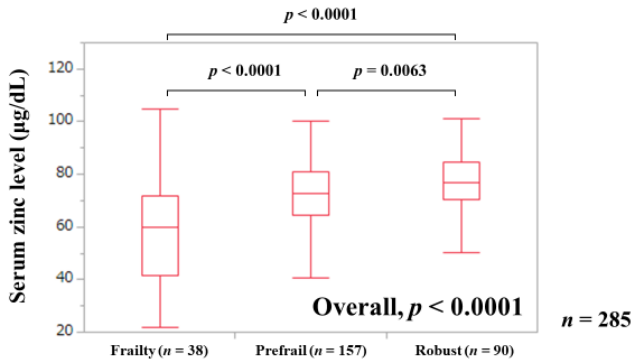
Figure 1. Serum Zn level according to the frailty status.